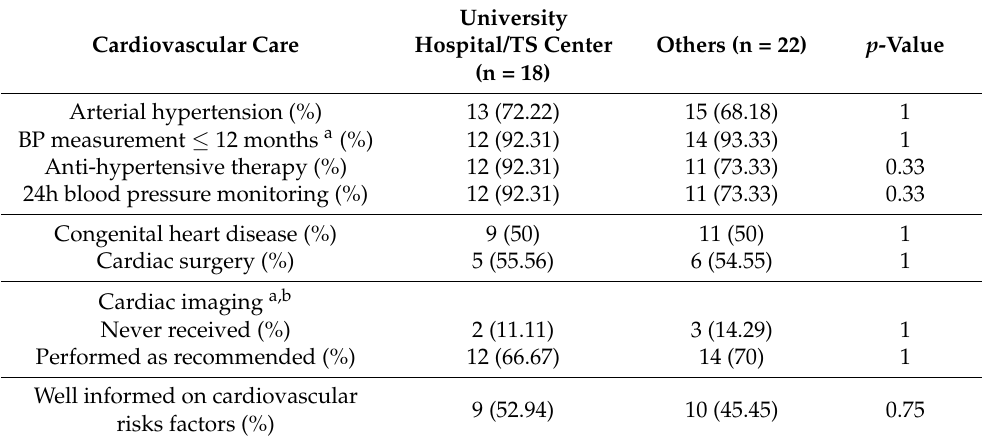
Table 3. Cardiovascular care of TS women with arterial hypertension and/or congenital heart disease in